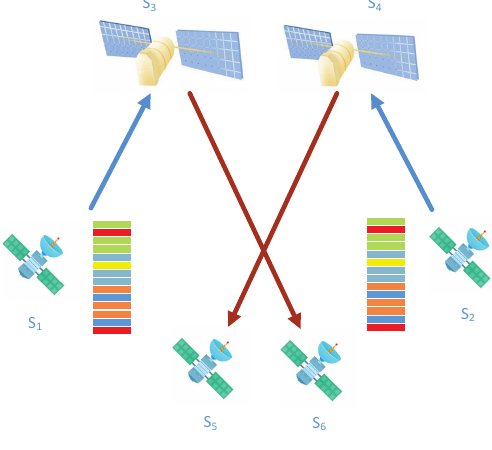
Figure 2. Mission offloading and re-offloading process of all the